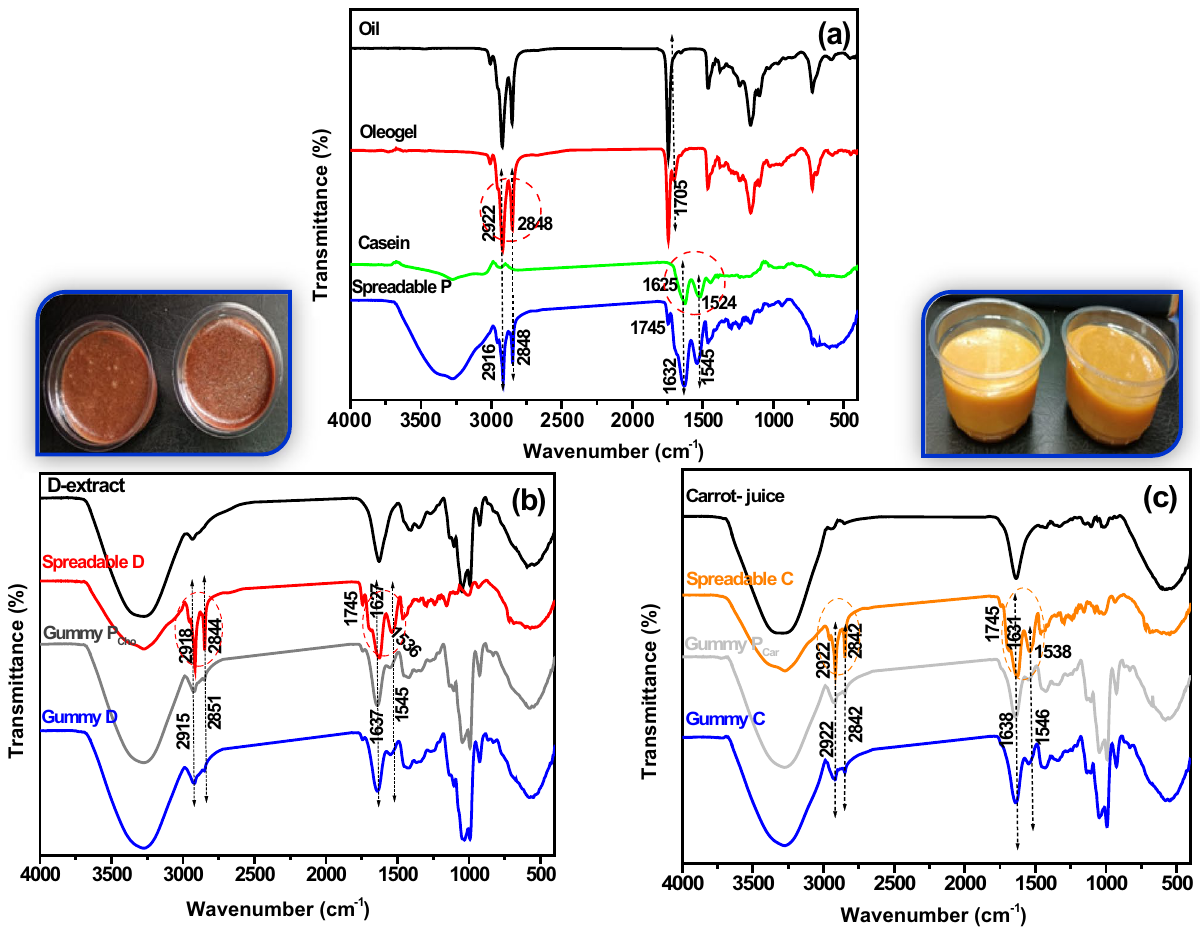
Figure 6. FTIR-ATR spectra of ( a ) spreadable P, ( b ) spreadable C, Gummy C, and ( c ) spreadable D, Gummy